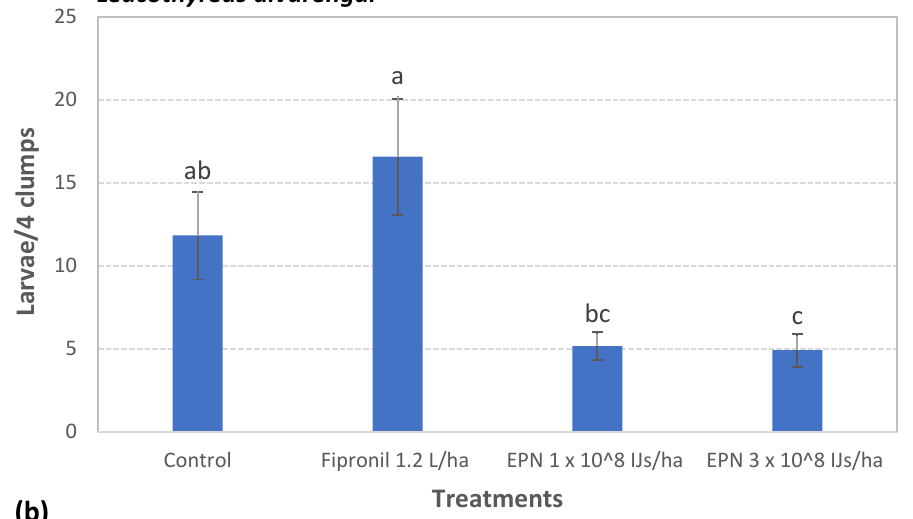
Figure 9. Population of Sphenophorus levis (larvae + pupa + adults) ( a ) and Leucothyreus alvarengai (larvae) ( b ) in a sugarcane field, 21 days after the application of Steinernema rarum (1 × 10⁸ IJs/ha and 3 × 10⁸ IJs/ha) and fipronil (1.2 L/ha). Means followed by different letters differ significantly by the Tukey test ( p < 0.005).